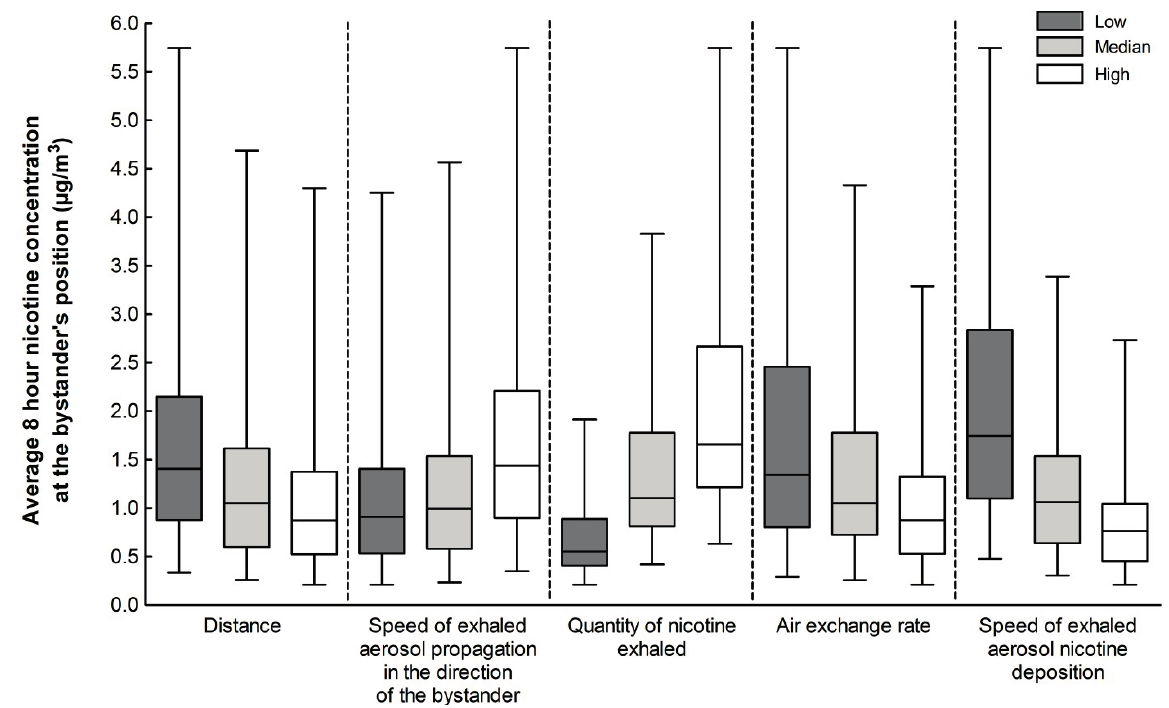
Figure 5. Impact that each parameter has on the calculated range of average 8 h nicotine concentrations in the ambient air at the bystander’s position. Each parameter is assigned three values: low (L), medium (M) or high (H). Distance of the bystander from the e-cigarette user, 1 (L), 1.5 (M) or 2 m (H); speed of exhaled aerosol propagation in the direction of the bystander, 0.5 (L), 1.0 (M) or 2.0 m/min (L); quantity of nicotine exhaled, 10 (L), 20 (M) or 30 μ g (H); air exchange rate from 1 (L), 2 (M) or 3 (H) air changes per hour; and speed of exhaled aerosol nicotine deposition, 0.01 (L), 0.03 (M) and 0.06 m/min (H). Boxes represent the 25th and 75th percentiles, lines inside the boxes are medians and whiskers represent minimum and maximum